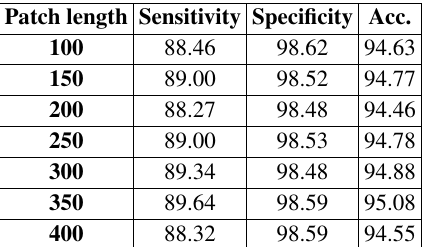
Table 1. CD results for the Santa Barbara scene using proposed method as the patch length is varied.